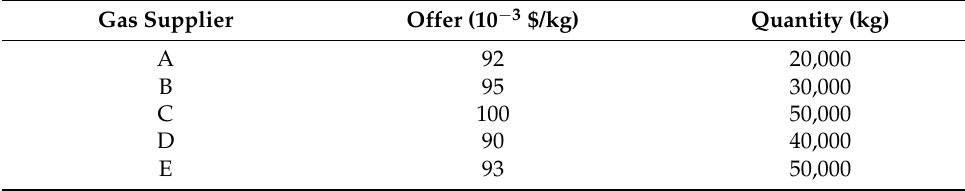
Table 3. Gas supply offers.